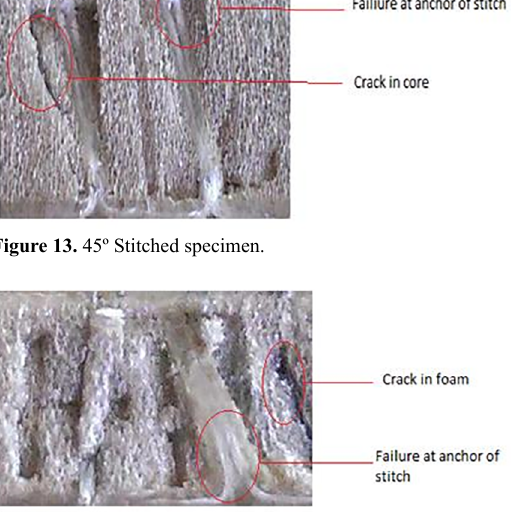
Figure 14. 90º/45ºStiched specimen.